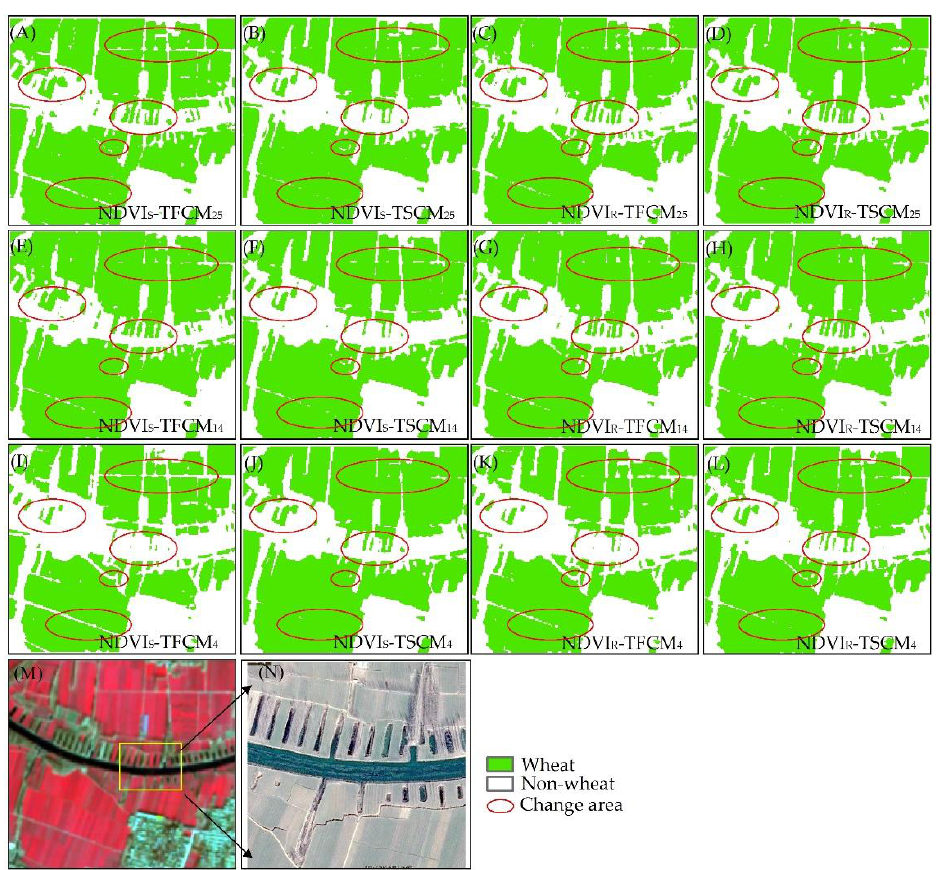
Figure 7. Comparison of crop classification accuracy between NDVI-TSCM and NDVI-TFCM over the second small region; the classification results of NDVI S -TFCM 25 ( A ), NDVI S -TSCM 25 ( B ), NDVI R -TFCM 25 ( C ), NDVI R -TSCM 25 ( D ), NDVI S -TFCM 14 ( E ), NDVI S -TSCM 14 ( F ), NDVI R -TFCM 14 ( G ), NDVI R -TSCM 14 ( H ), NDVI S -TFCM 4 ( I ), NDVI S -TSCM 4 ( J ), NDVI R -TFCM 4 ( K ), and NDVI R -TSCM 4 ( L ); a standard false color composite image using the ZY-3 data of 2 December 2014 ( M ); a small area that was obtained from Google Earth on 8 February 2015(N).